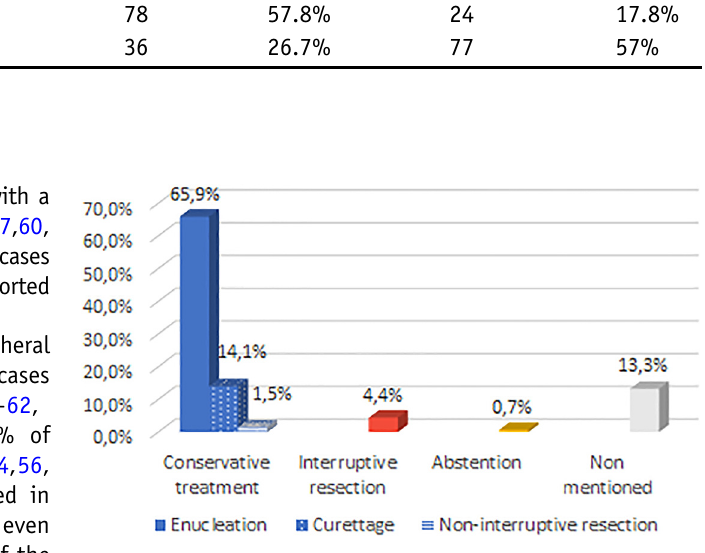
Fig. 4. Therapeutic approaches used in the treatment of central odontogenic fi